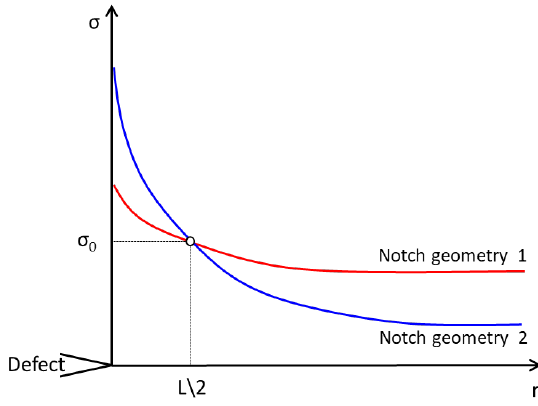
Figure 3. Determination of inherent strength σ 0 and critical distance L leveraging on the so called point method. “Notch geometry 1” and “notch geometry 2” are here used to generally describe two different notch geometries, in which “notch geometry 2” has a more severe notch than “notch geometry 1”.